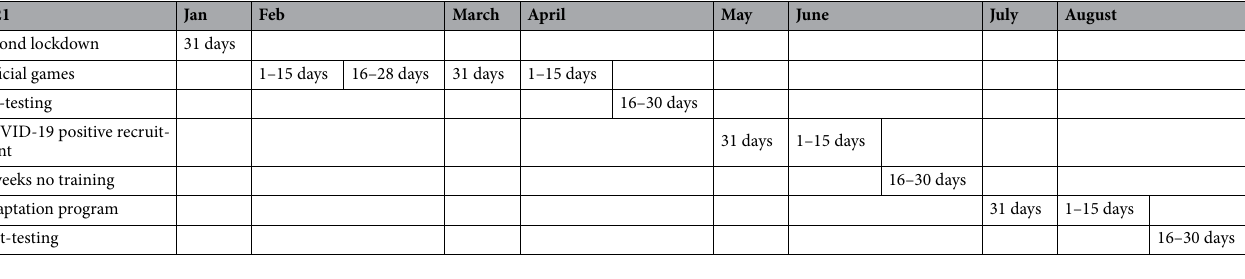
Table 1. Testing